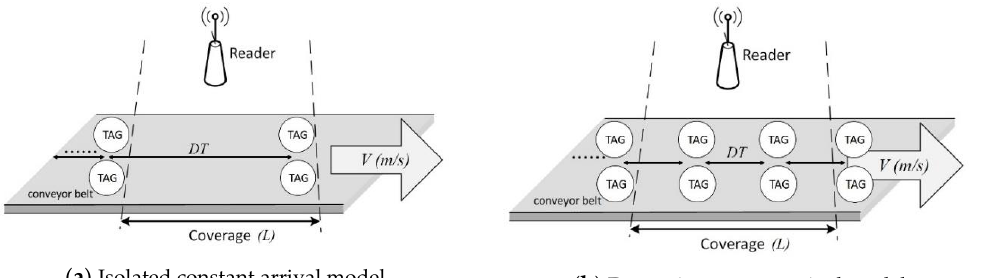
Figure 4. Examples of dynamic tag models.